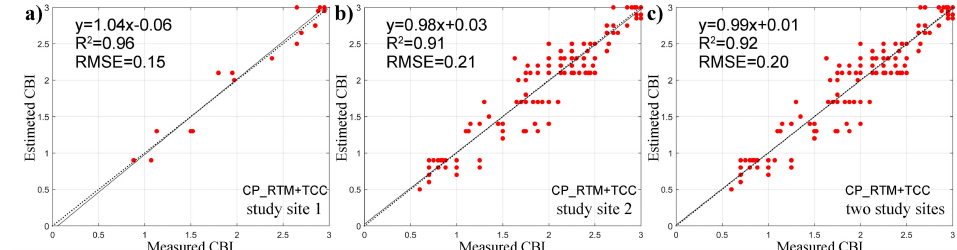
Figure 6. Field measured versus estimated burn severity (expressed as CBI) based on the method proposed in this study (CP_RTM + TCC) for ( a ) study site 1, ( b ) study site 2, and ( c ) two study sites. The dotted line and solid line represent the 1:1 line and fitting line,